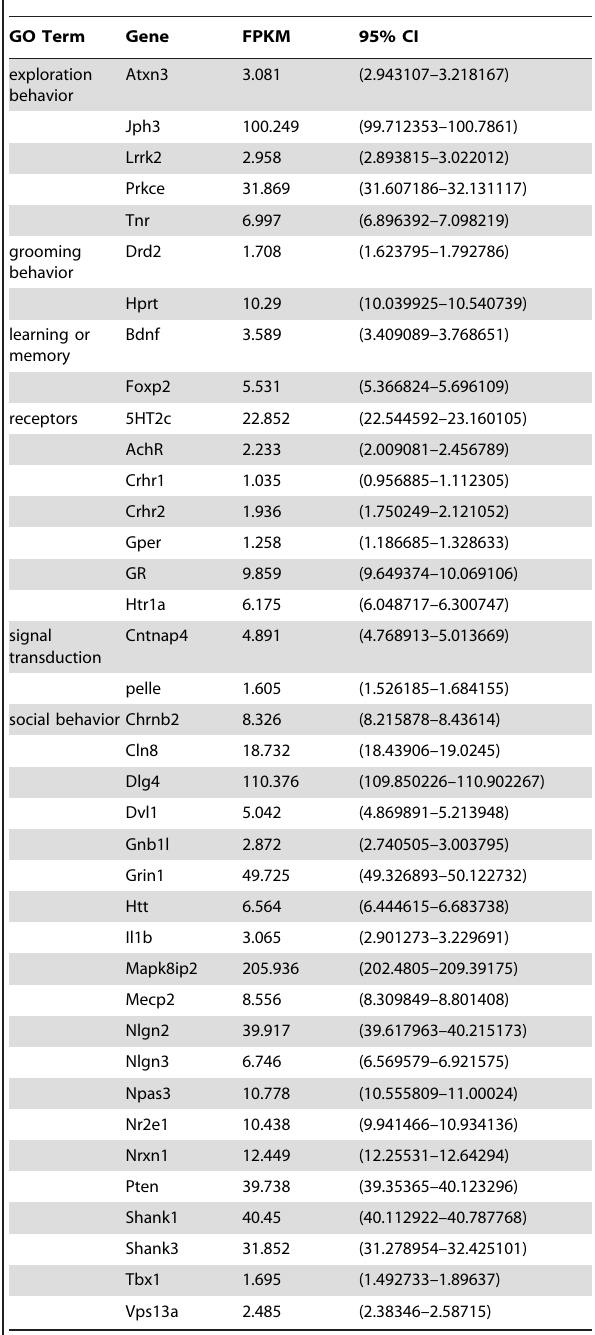
Table S1 A list of all GO terms grouped by biological process.